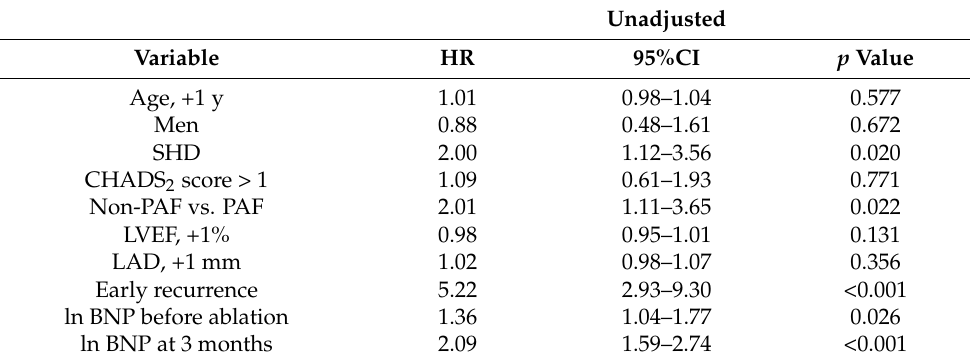
Table 2. Factors associated with arrhythmia recurrence after AF